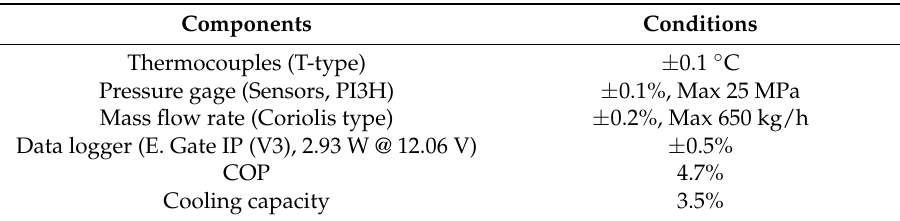
Table 4. Uncertainties of the experimental parameters and measured data. COP: coefficient of